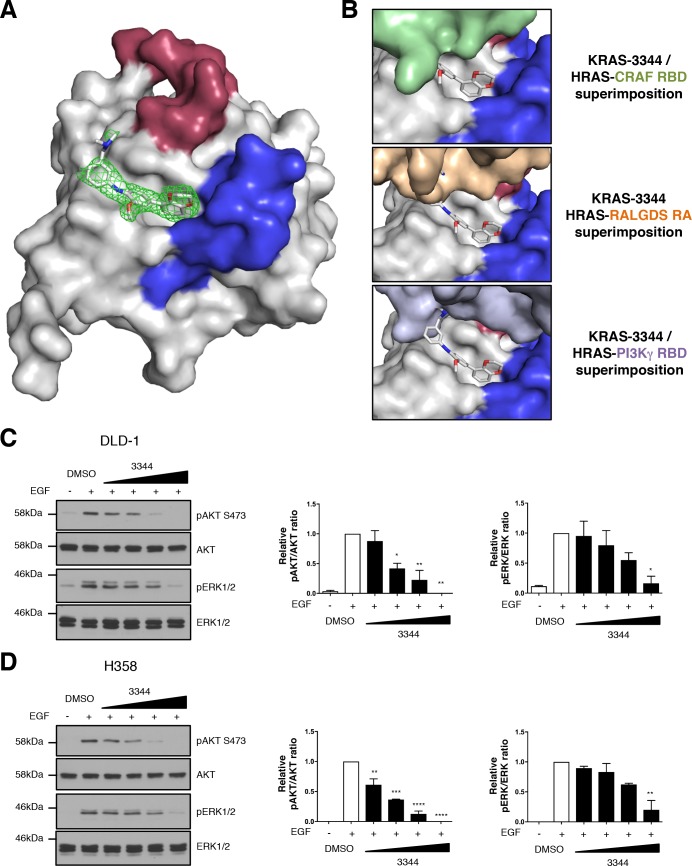
Compound 3344 interacts in a pocket close to the switch regions of KRAS.The interaction of mutant KRAS with compound 3344 was analyzed by X-ray crystallography. (A) KRASQ61H crystals were soaked with 3344 compound and crystal structures obtained from X-ray diffraction. The compound is shown binding in the hydrophobic pocket near switch I (shown in red) and switch II (shown in blue). The electron density map of the compound (2Fo-Fc) is shown as green mesh, and contoured at 1.0 rms. (B) We have modeled the potential interactions that could prevent 3344 and a RAS effector binding simultaneously to the same RAS molecule by overlaying our structure of the KRAS-3344 complex onto the published structures of top panel: HRAS-CRAF RBD (PDB 4G3X), middle panel: HRAS-RALGDS RA (PDB 1LFD), bottom panel: HRAS-PI3Kγ RBD (PDB 1HE8). (C, D) Two human mutant KRAS expressing lines (C: DLD-1 and D: H358) were serum-starved for 24 hr and treated 3 hr with different concentrations of 3344 (2, 5, 10 and 20 μM) before stimulation with EGF (50 ng/mL) for 10 min. Cells were harvested, proteins extracted and separated by SDS-PAGE for western blot analysis. Western membranes were treated with anti-pAKT S473; anti-pan AKT; anti-pERK1/2 and anti-ERK1/2 as indicated. Statistical analyses of pERK/ERK and pAKT/AKT quantifications were performed using a one-way ANOVA followed by Dunnett’s post-tests (*p<0.05, **p<0.01, ***p<0.001, ****p<0.0001). Where error bars are presented, they correspond to mean values ± SEM of biological repeats (C–D). Each experiment was performed twice (C–D).